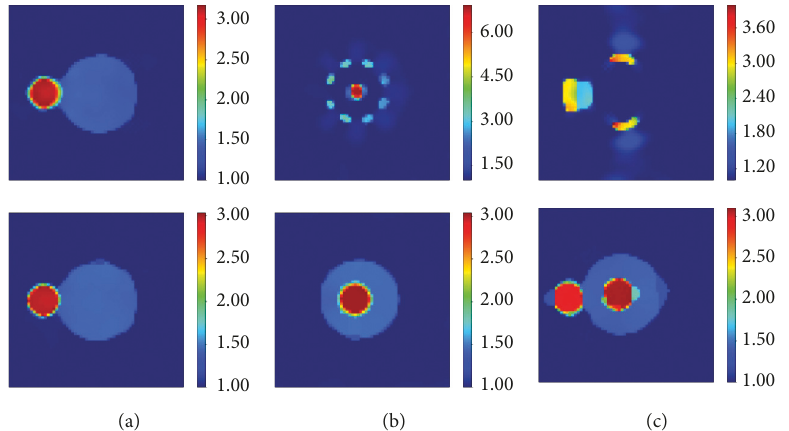
Figure 9: The multifrequency MR-CSI inversion results (first row) and the multifrequency MR-IO-CSI inversion results (second row) of (a) ‘FoamDielExtTM,’ (b) ‘FoamDielIntTM,’ and (c) ‘FoamTwinDielTM’ at 5 GHz, 6GHz, 7GHz, and 8 GHz.